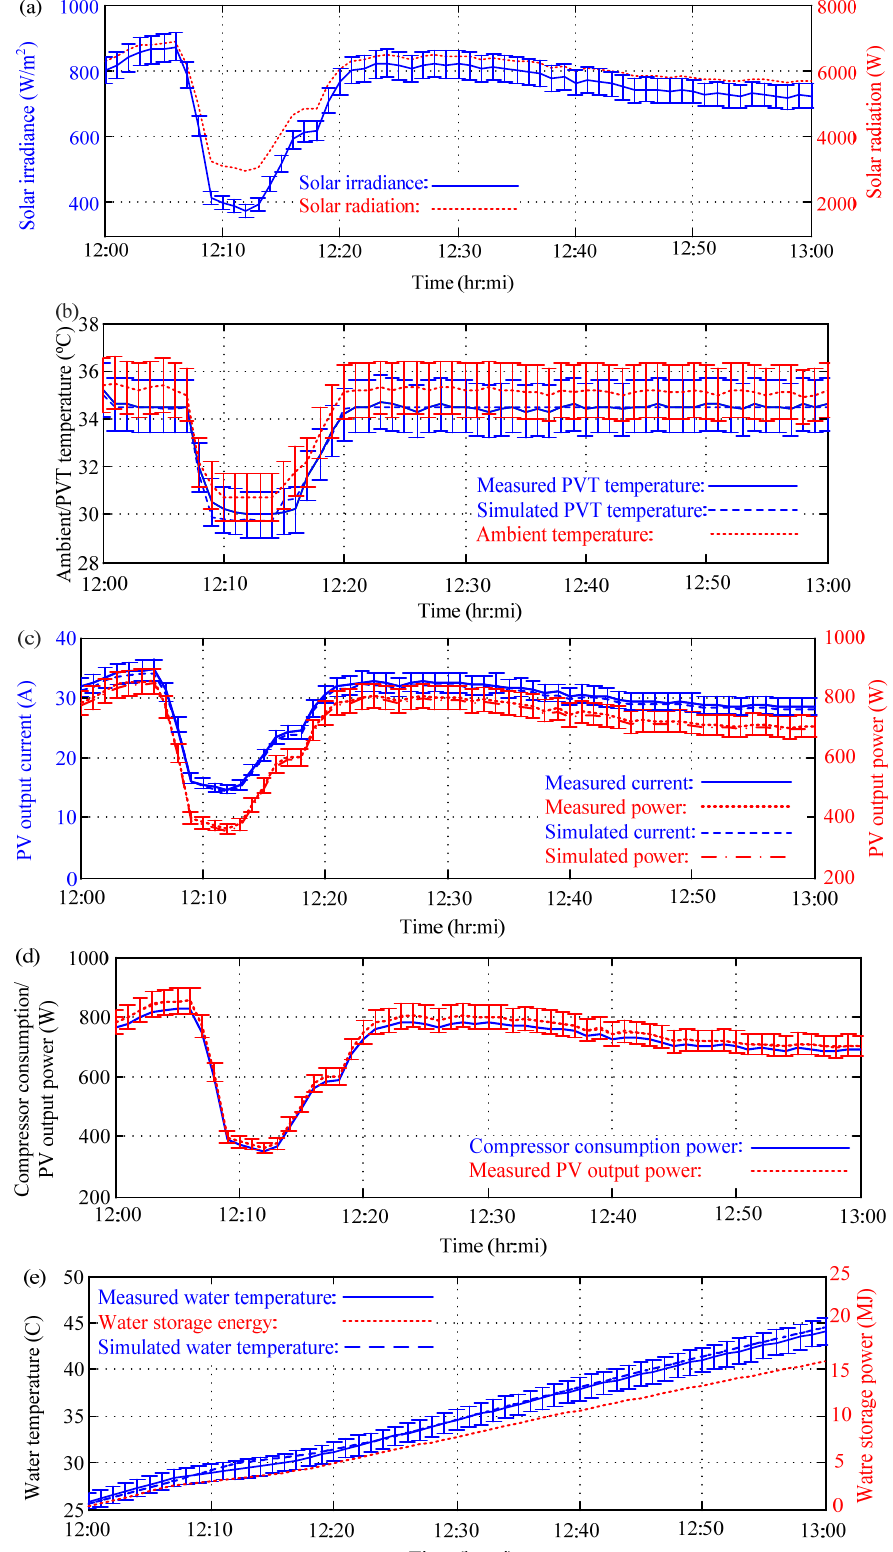
Figure 7. Measured and simulated data on a mostly sunny day (1 2 June 2013): ( a ) Solar irradiance and radiation; ( b ) Ambient and PVT temperatures; ( c ) Measured and simulated PV output current and its power; ( d ) Compressor power and measured PV output power; ( e ) Measured and simulated water temperature and tank storage